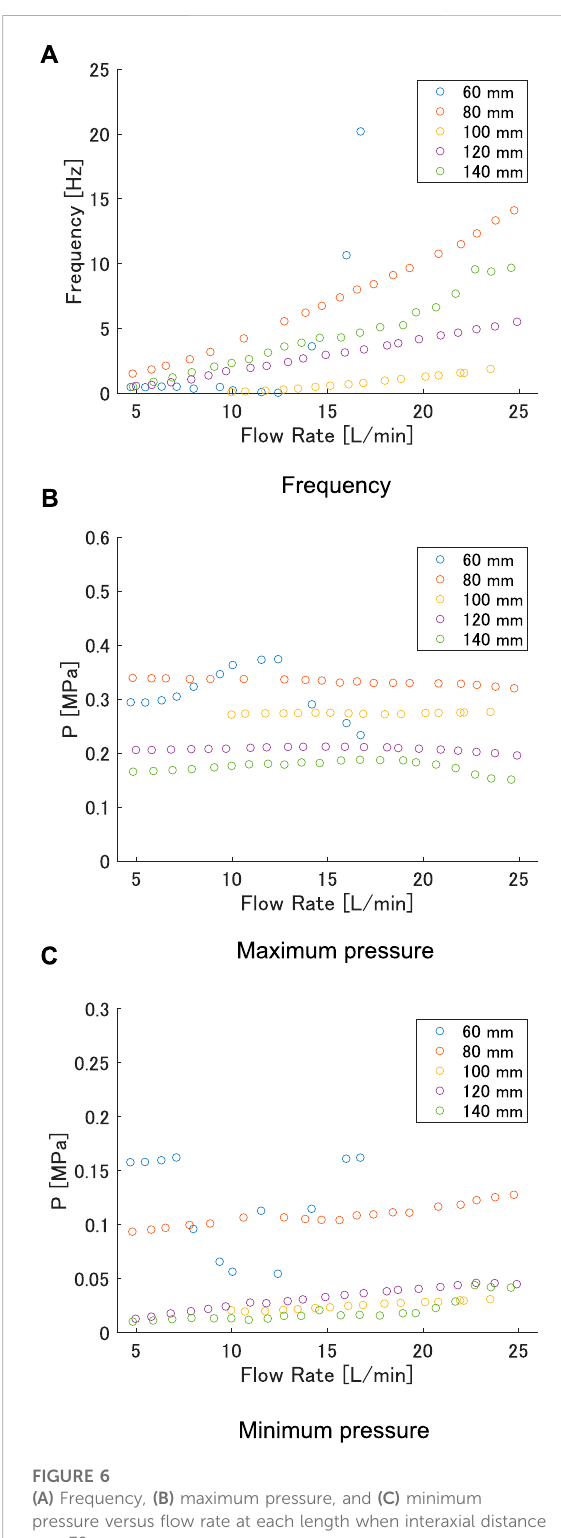
FIGURE 6 (A) Frequency, (B) maximum pressure, and (C) minimum pressure versus fl ow rate at each length when interaxial distance was 32